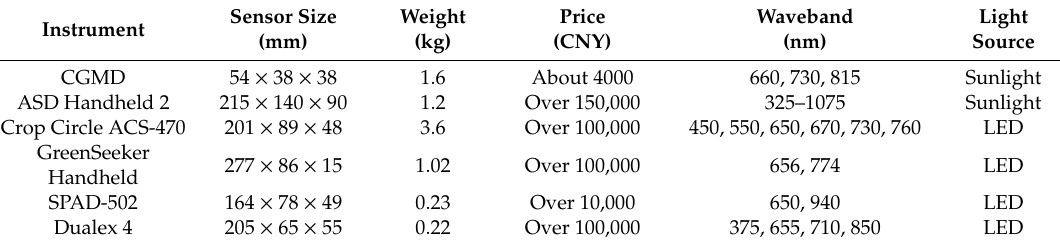
Table 1. The parameters of some instruments of crop-growth monitoring.